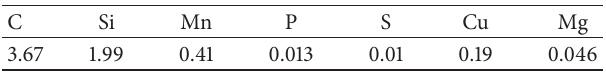
Table 1: Chemical composition of the spheroidal graphite cast iron (mass%).